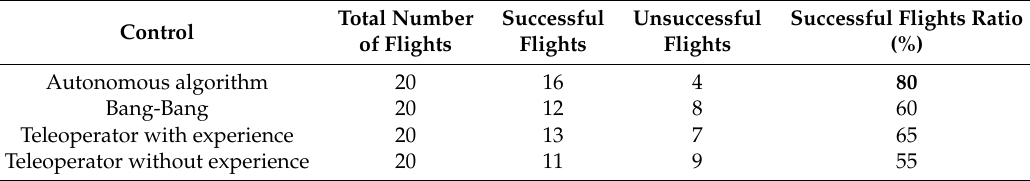
Table 5. Results of flights with different controls.